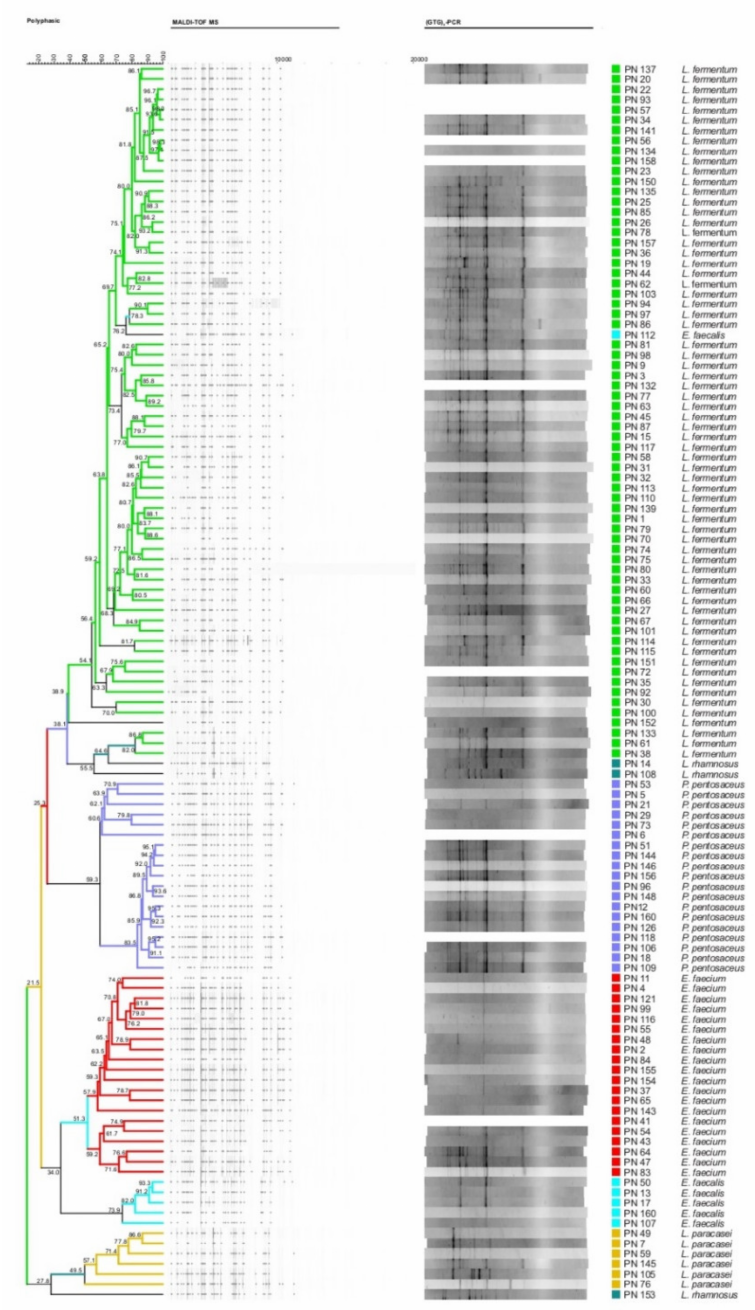
Figure 1. UPGMA dendrogram of the Rep-PCR and matrix-assisted laser desorption/ionisation time-of-flight mass spectrometry (MALDI-TOF MS) analyses of presumptive non-starter lactic acid bacteria (NSLAB) isolated from semi-hard Provola dei Nebrodi PDO (PN) cheese samples. Node values indicate the average percentage of similarity based on (GTG) 5 -PCR and MALDI-TOF MS profiles. The tree was made with BioNumerics version